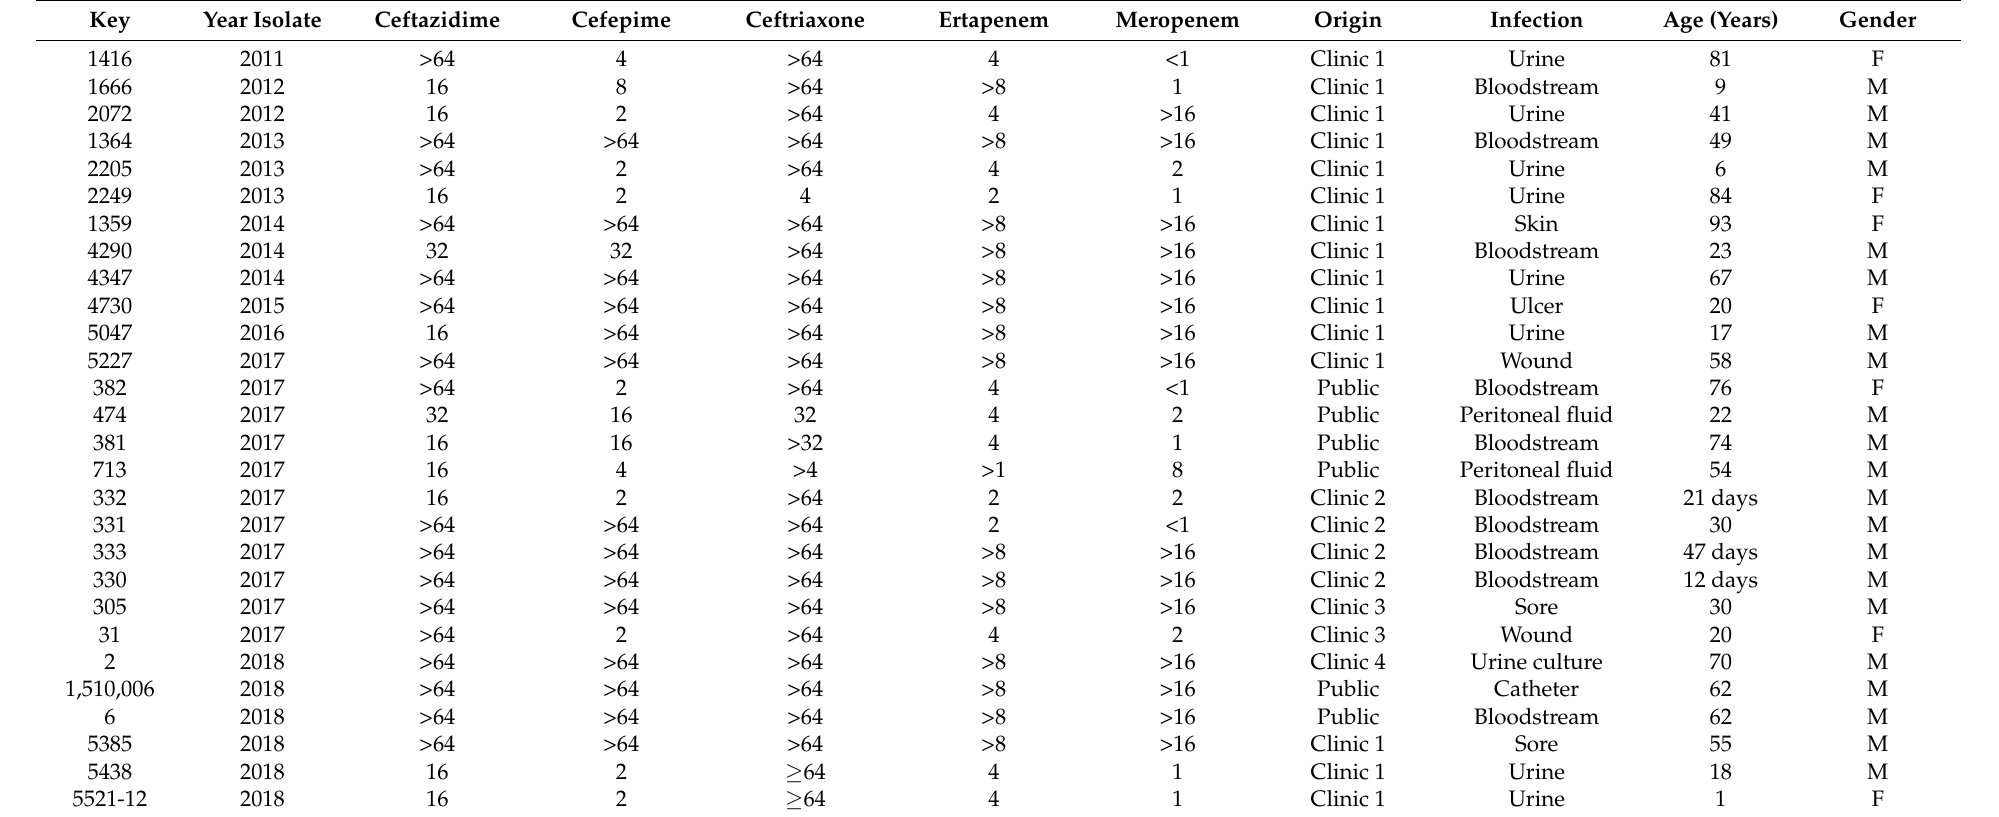
Table 1. Antibiotic susceptibility profile and demographic data of the E. cloacae complex isolates included in this